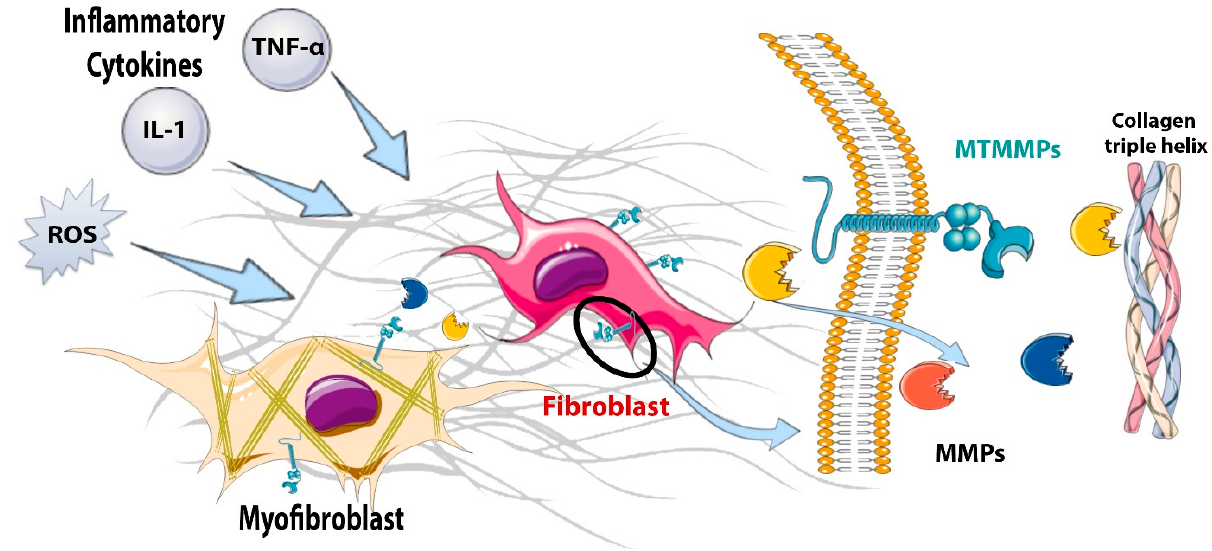
Figure 2. The matrix-degrading properties of fibroblasts in the infarcted myocardium. During the inflammatory phase of infarct healing, pro-inflammatory cytokines, such as interleukin (IL)-1 β , tumor necrosis factor (TNF)- α , and IL-6 stimulate the expression and secretion of matrix metalloproteinases (MMPs) that degrade the extracellular matrix, setting the stage for the replacement of damaged tissue with a collagen-based scar. During the inflammatory and early proliferative phases of infarct healing, the induction of membrane-type matrix metalloproteinases (MT-MMPs) on the cell surface plays an important role in fibroblast migration, thus localizing the reparative fibroblasts to the area of infarction.